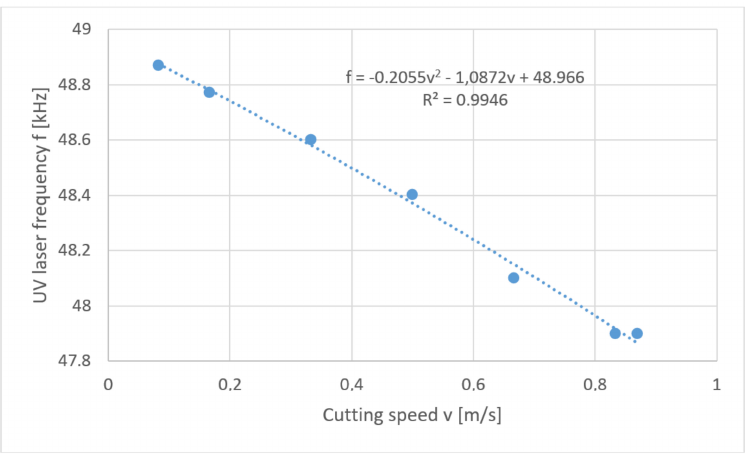
Figure 12. Reverse task solution for cutting foil with thickness t = 50 µm.